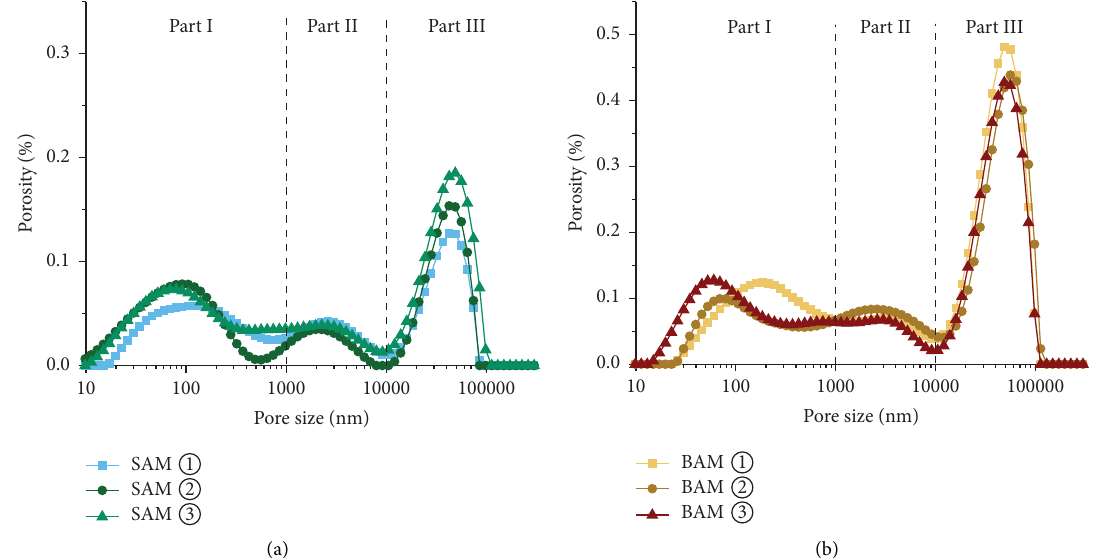
Figure 5: Aperture distribution curve of two asphalt mixtures: (a) aperture distribution curve of SAM; (b) aperture distribution curve of BAM. Table 5: Pore characteristic parameter of SAM and BAM. SAM